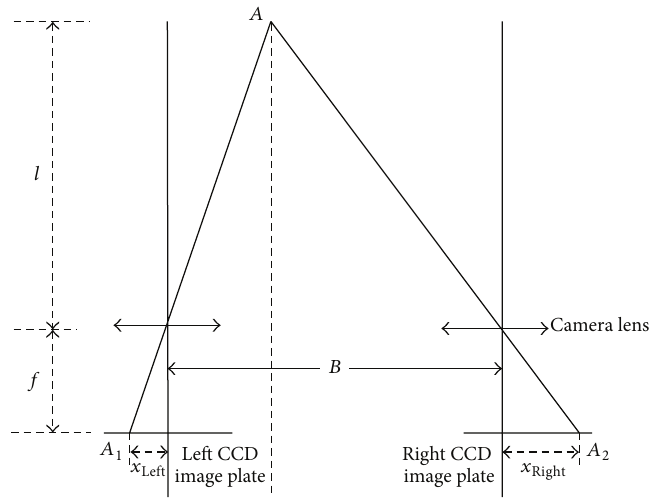
Figure 1: Schematics of binocular CCD